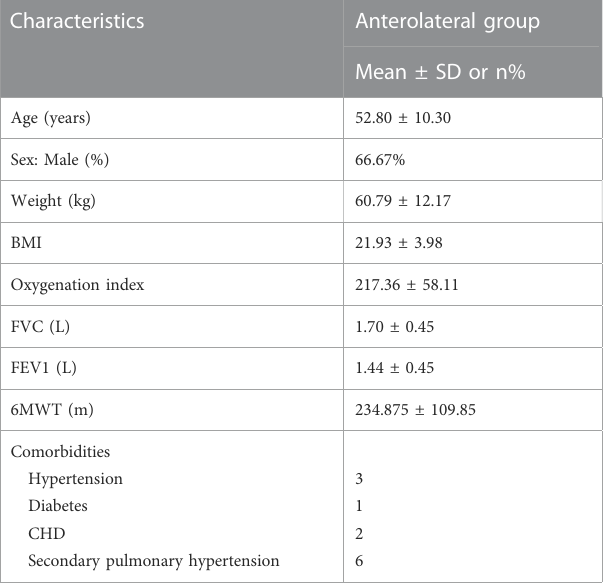
TABLE 2 Baseline characteristics of the